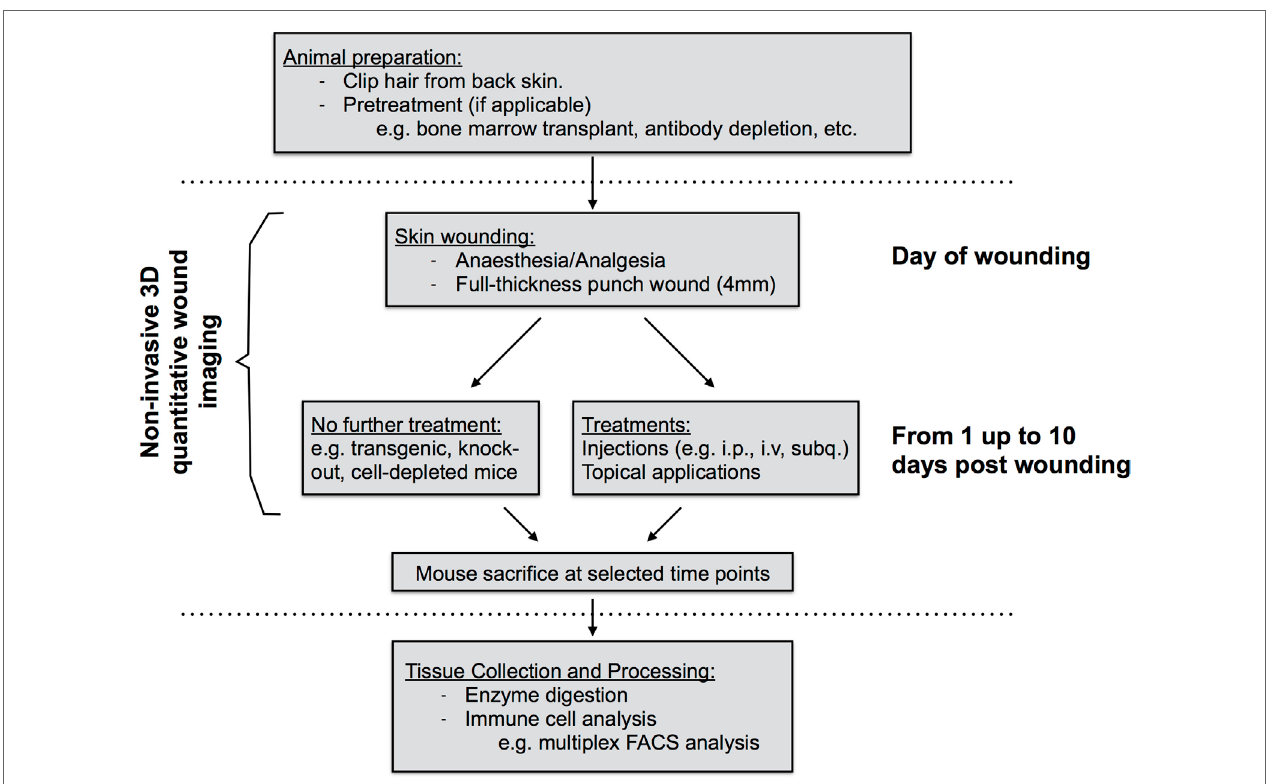
FIgURe 1 | Diagram of work flow of mouse skin wound experiment procedures. Prior to wounding, hair must be clipped from the back skin. Common pretreatments can also include whole-body irradiation followed by bone-marrow transplantation or antibody depletion of cell populations prior to wounding. On the day of wounding and all subsequent days, wounds are imaged non-invasively using 3D image capture and may be exposed to further treatments if required. At sacrifice, back skin wound tissues are collected, subjected to enzyme digestion, and isolated cells processed for analysis by flow